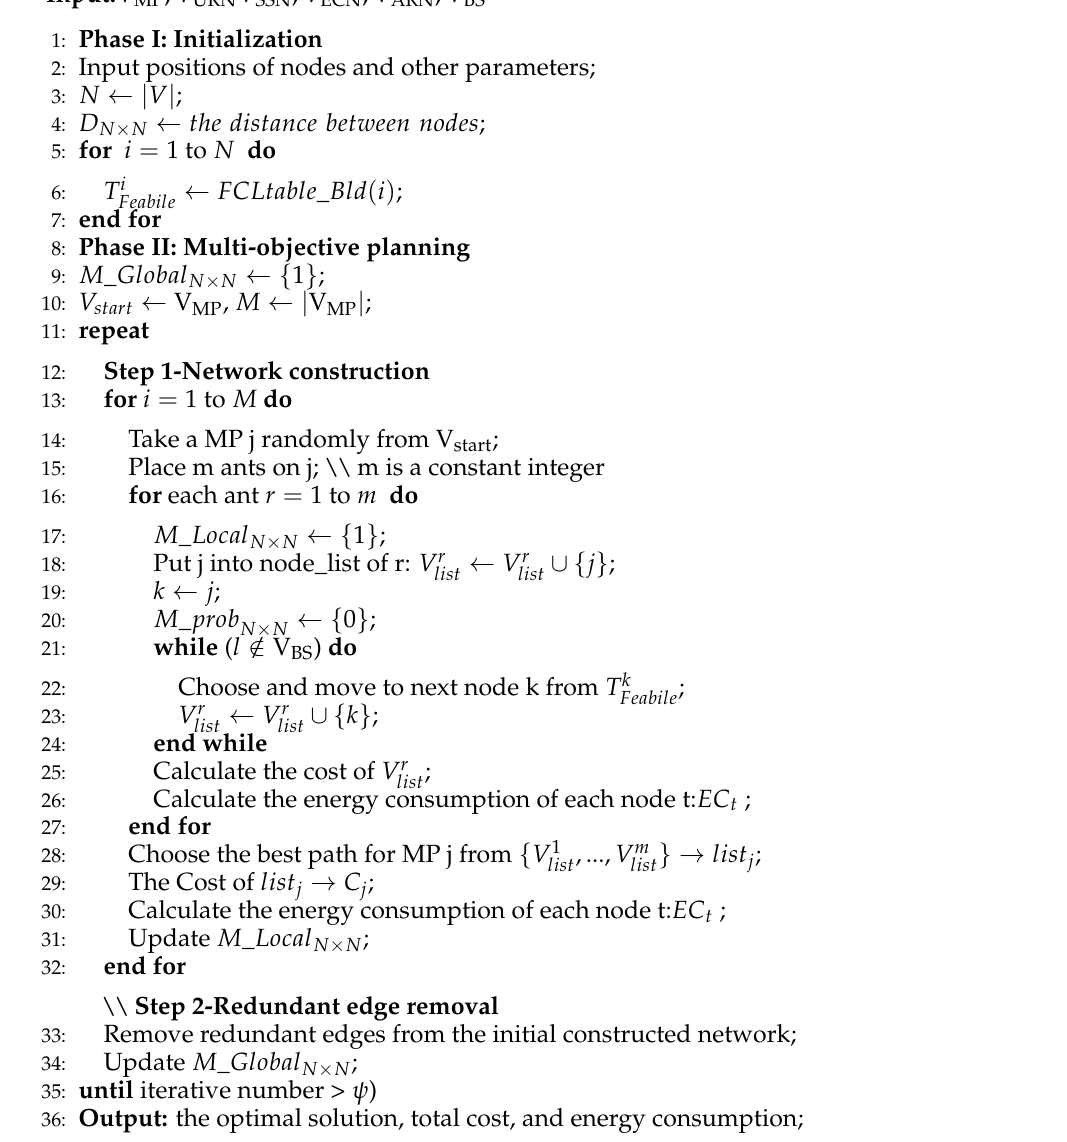
Algorithm 1 The pseudo code of AC-ETO